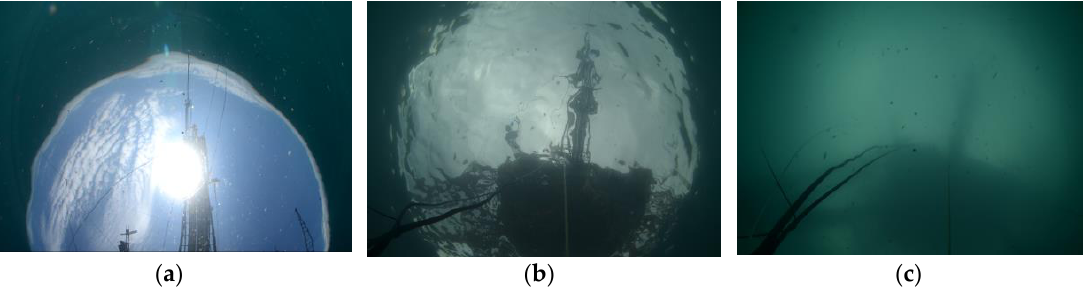
Figure 1. The Snell ’ s window image obtained from oceanographic platform in the Black Sea ( a ) for a flat sea surface from depth of 0.5 m and for a rough sea surface from depths of ( b ) 1.5 m and ( c ) 5 m (attenuation coefficient was about 0.6 m − 1 ).